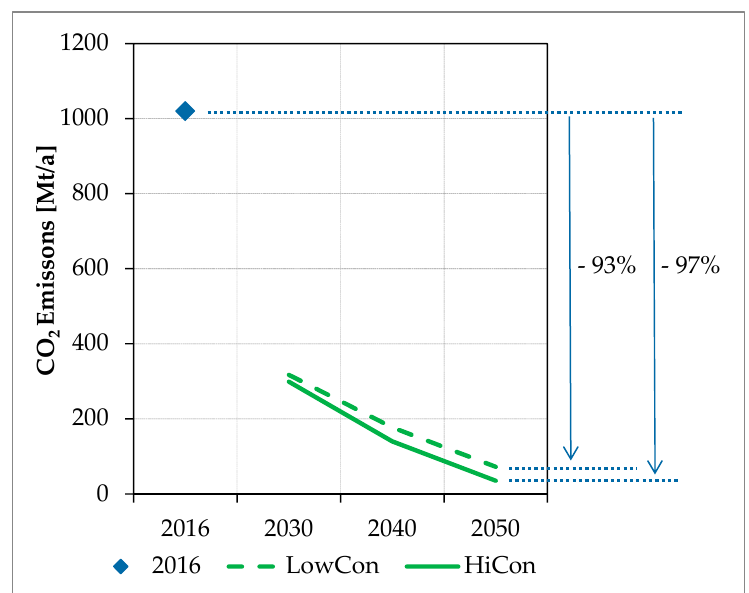
Figure 12. Development of CO 2 emissions in the ENTSO-E area. Source: 2016 [40,41].